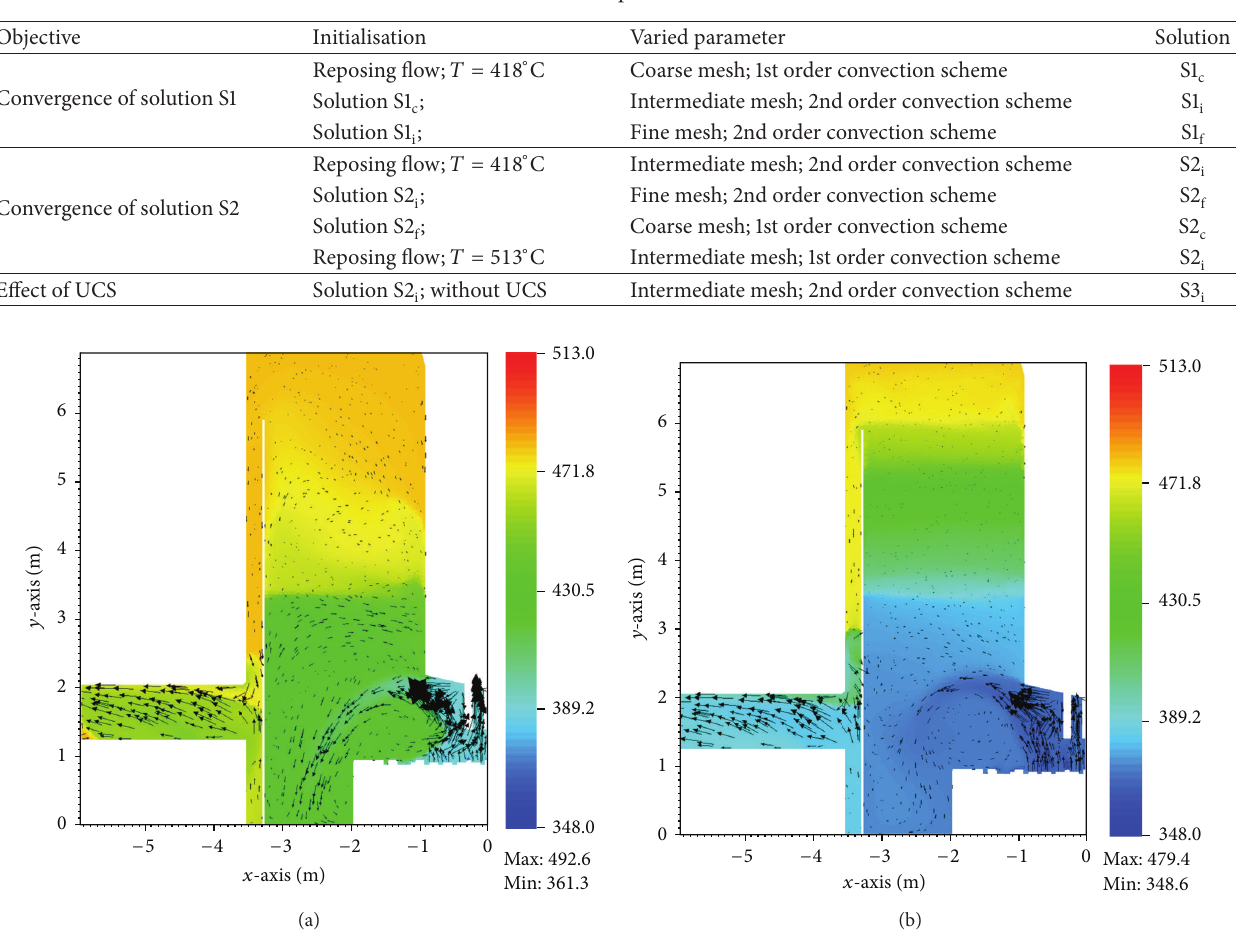
Figure 7: (a) The flow field in the symmetry plane at 𝑡 = 2 min. (b) The flow field in the symmetry plane at 𝑡 = 10